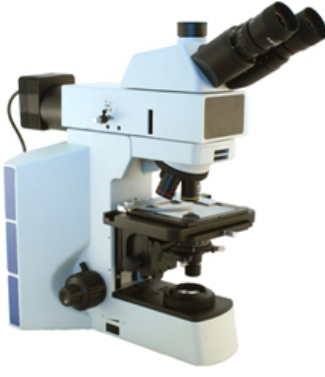
Figure 8: Metallurgical Microscope